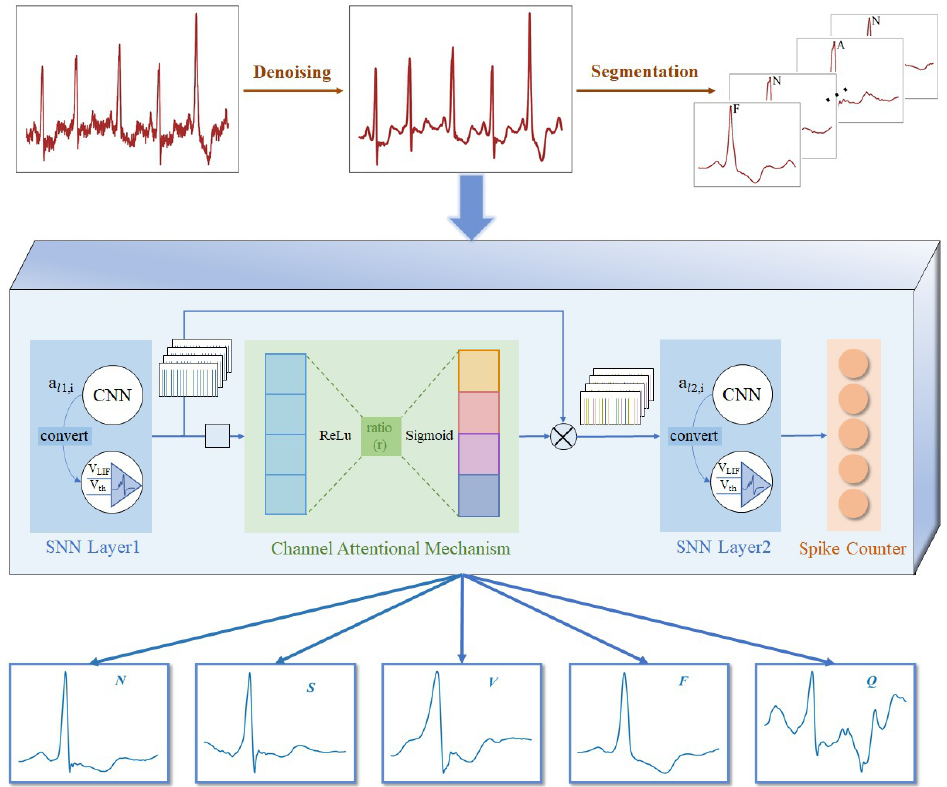
Figure 3. System framework of automatic diagnosis for ECG arrhythmia. The last component selects the neuron with maximum spike frequency as the heartbeat’s class.